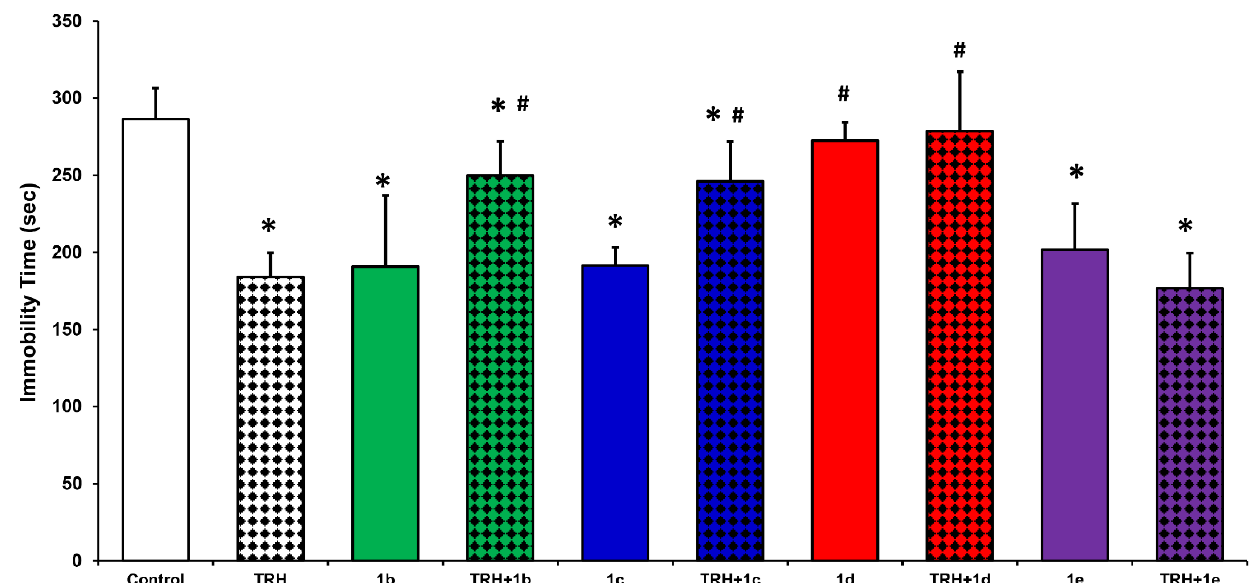
Figure 3. Mean immobility times in the Porsolt swim test for animals injected with [Glu 2 ]TRH-like peptides ( 1b – d , Figure 1) alone or together with TRH (i.p., 3 µmol/kg body weight, each). The control animals received saline vehicle (30 µL). An equimolar dose of TRH was used as a positive control. The behavioral test began 30 min after the test agent administration. Each experiment was conducted for 6 min, and the duration of immobility was recorded during the last 4 min. Immobility of the animal is defined as floating motionless, making only movements to keep the head above the water. An antidepressant-like effect is indicated by a decrease in the duration of immobility compared with the control group. Data are expressed as average ± SD. ANOVA followed by post hoc Tukey’s tests ( p < 0.05, n = 10–12): * indicates statistically significant difference from control, # indicates statistically significant difference from TRH alone.